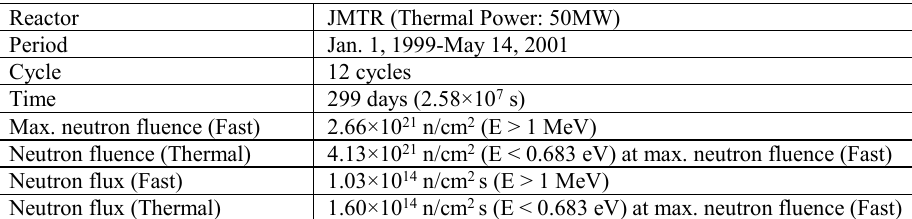
Table 2. Irradiation conditions of